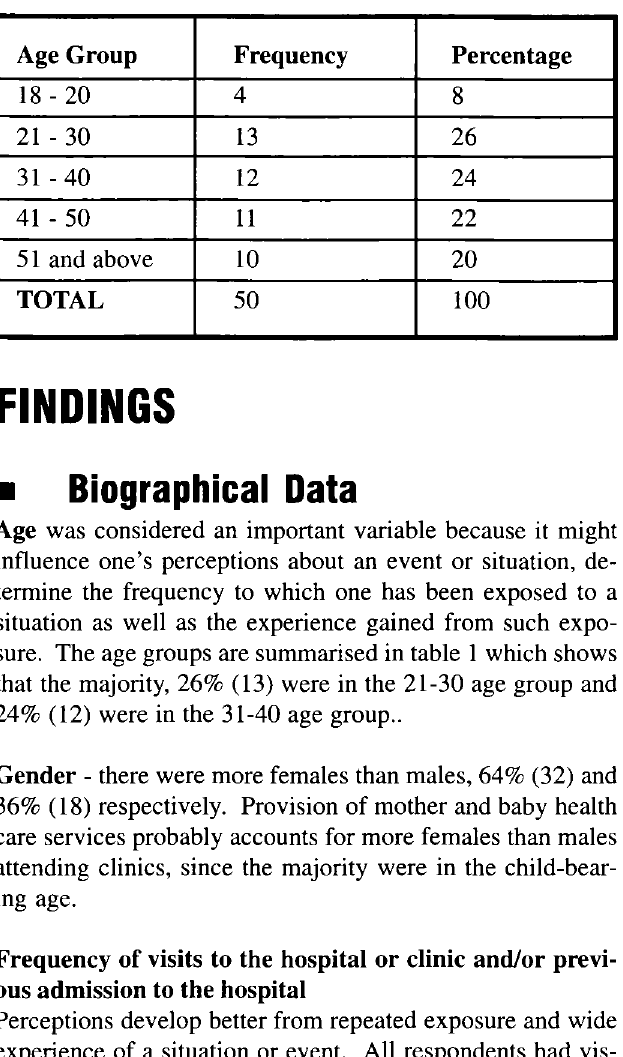
Table 1 : Age distribution (n = 50)